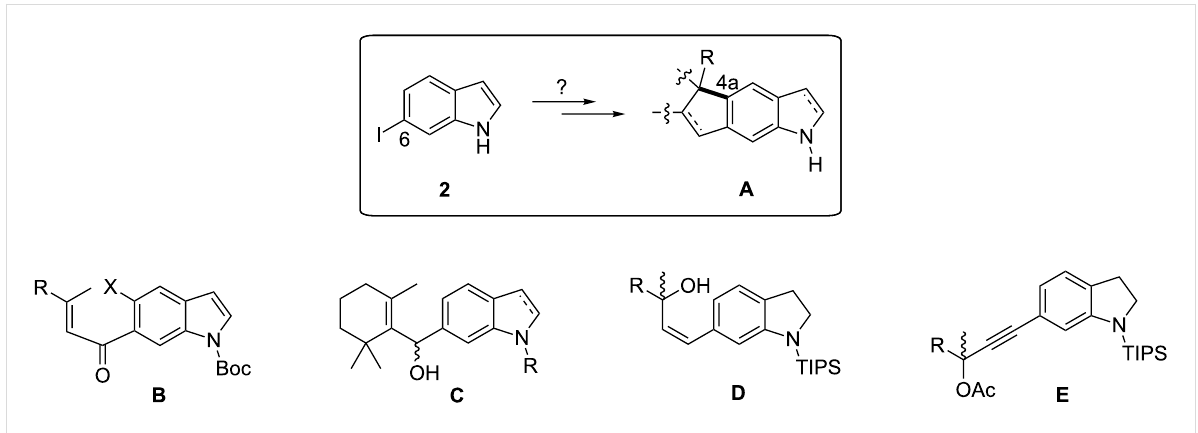
dole to a mixture of cyclopenta[ f ]- and -[ g ]indoles in a Nazarov- type reaction [34]. By installation of a triflyloxy group in the indole 5-position, Pd-catalyzed cyclization also would become possible. As an alternative to the cyclization of enones, Lewis acid-induced cyclizations of allylic alcohols could afford the desired cyclopenta[ f ]indole system ( C , D ). Here, it was unclear whether the indole enamine section would be tolerated or have to be reduced prior to cyclization. Finally, propargyl alcohol de- rivatives ( E ) were to be investigated as substrates of Pt(II) and Au(I)-catalyzed reactions. All of the investigated building blocks were to be obtained from 6-iodoindole ( 2 ), which was synthesized via the Batcho–Leimgruber route and purified by sublimation